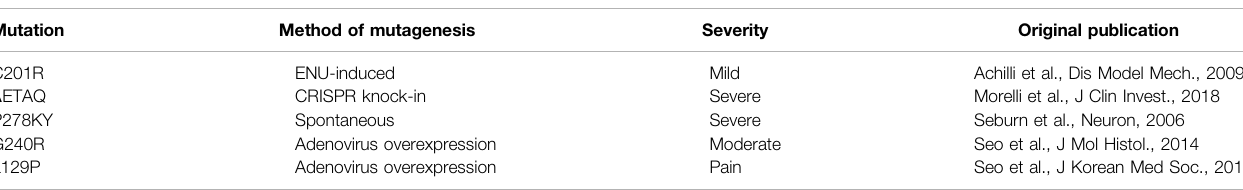
TABLE 1 | Current mouse models of Gars /CMT2D.